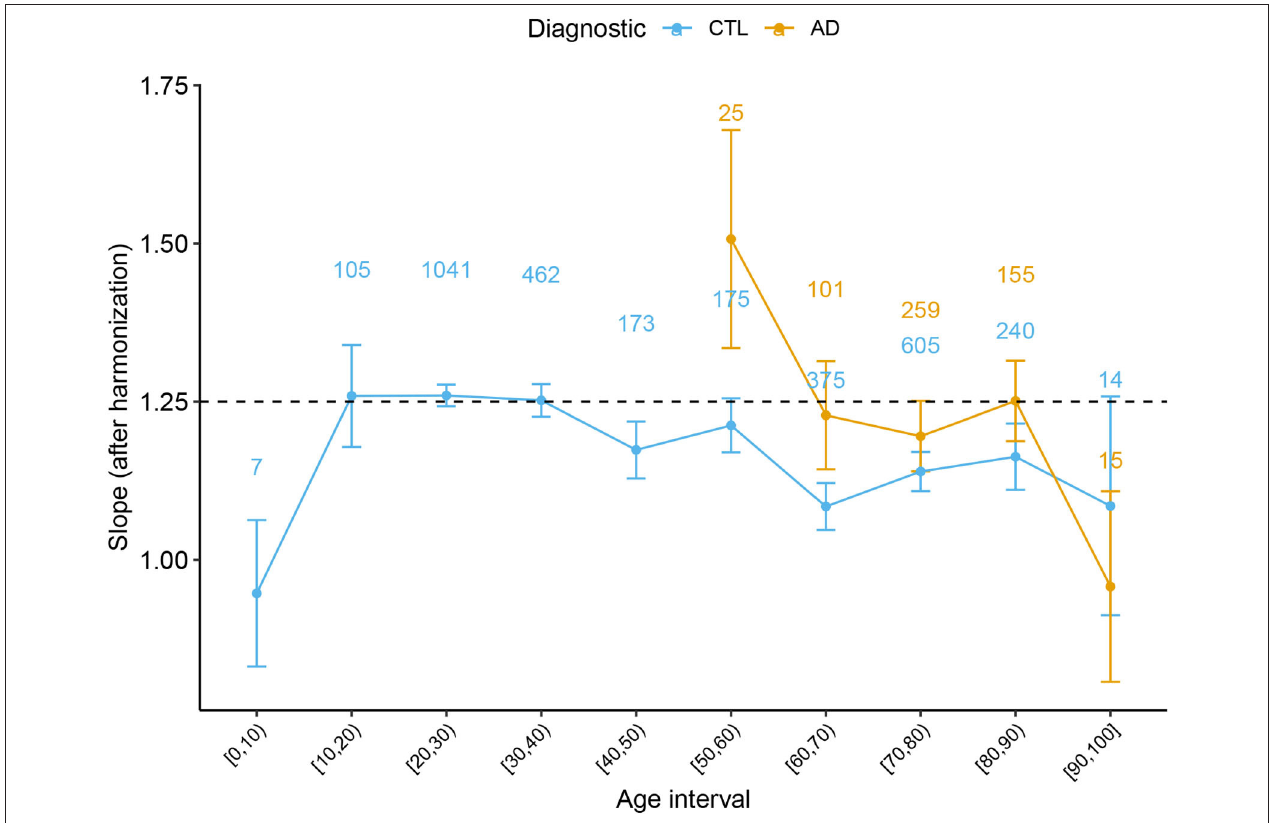
FIGURE 4 | Slope α with 95% CI derived from the Cortical Folding model from Mota and Herculano-Houzel through age for Healthy Controls and AD subjects. Data points from (0, 5] and [95, 100] years old were omitted due to the reduced data. The numbers on top of each point indicate the number of subjects at each